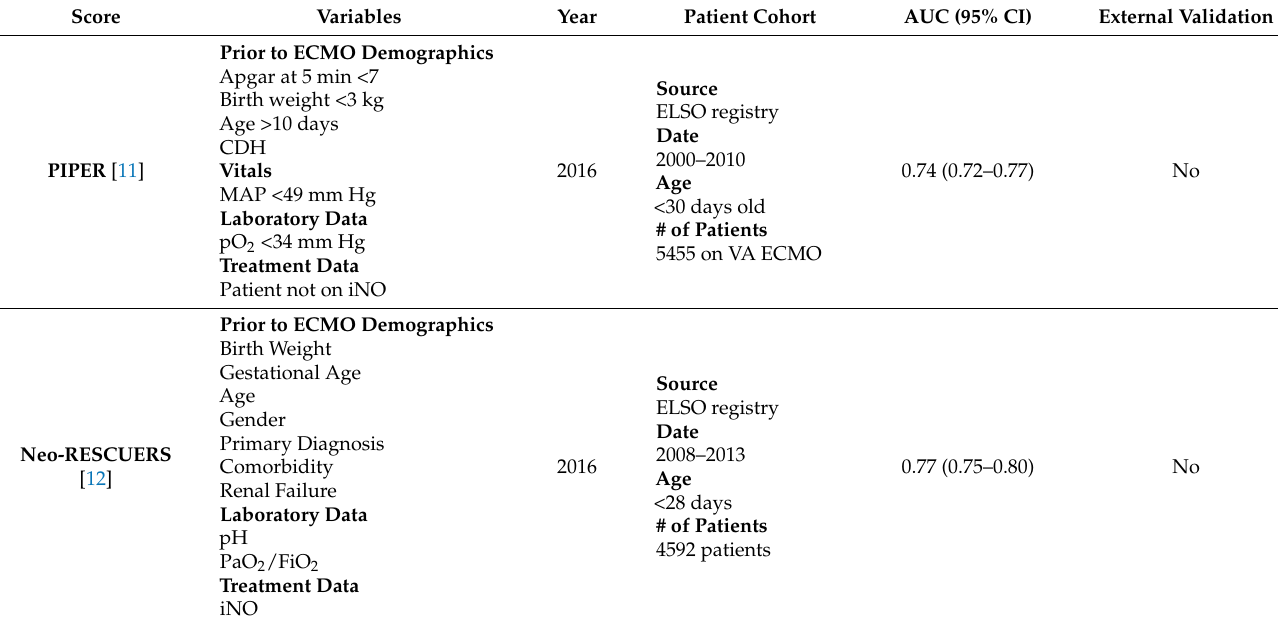
Table 1. Prognostication scores for neonatal respiratory